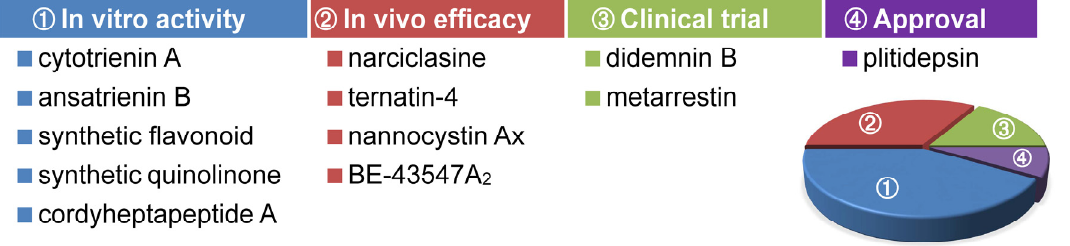
Figure 9. Development status of eEF1A-targeting small-molecule anticancer agents, among which narciclasine, ternatin-4, nannocystin Ax, and BE-43547A 2 have been validated in at least one in vivo preclinical model, didemnin B and metarrestin have been or currently are being studied in clinical trials, and plitidepsin has gained approval for clinical use. These three groups of compounds are at more advanced development stages than the leftmost group, making up over half of the whole collection of anticancer eEF1A inhibitors discernible from the accompanying pie chart. Their validated efficacy in preclinical models or clinical cohorts lends concrete support to the principle of targeting eEF1A with viable anticancer selectivity.